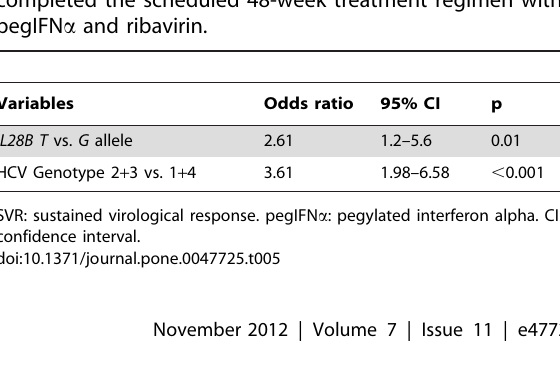
Genotype/allele